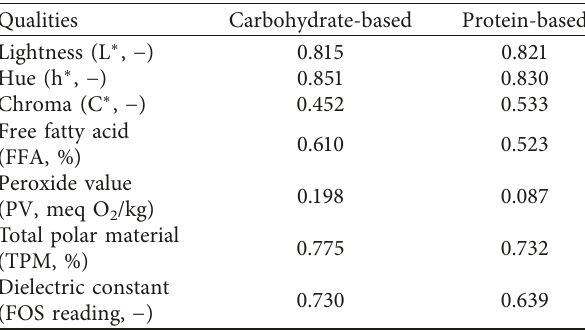
Table 1: Regression results of parameter values obtained from CVS and physicochemical qualities of frying